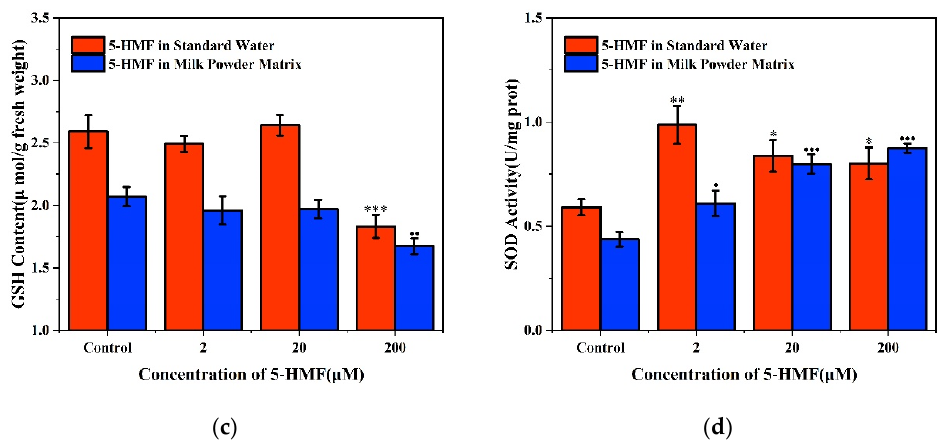
Figure 4. Effect of high, medium and low concentrations of 5-HMF on zebrafish embryos exposed to different matrices for 120 h. ( a ) Effect of 5-HMF in different matrices on the body length of zebrafish larvae; ( b ) Effect of different concentrations of 5-HMF in two matrices on the MDA content of zebrafish embryos; ( c ) Effect of different concentrations of 5-HMF on GSH content of zebrafish embryos in two matrices; ( d ) Effect of different concentrations of 5-HMF in two matrices on SOD activity of zebrafish embryos. * or ● p < 0.05, ** or ●● p < 0.01 and *** or ●●● p < 0.001 vs. control.